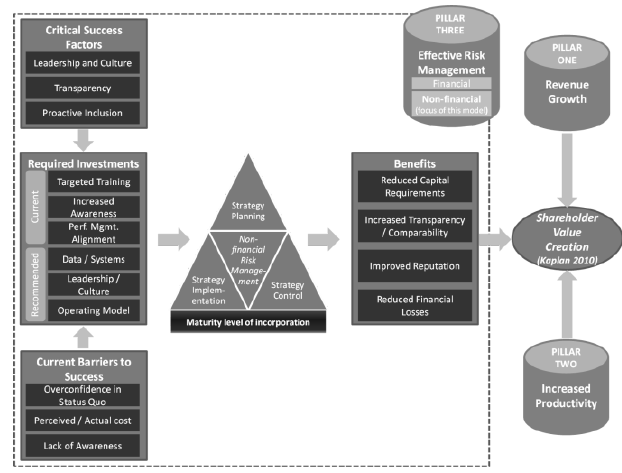
Figure 3: Effective risk management as a pillar of shareholder value